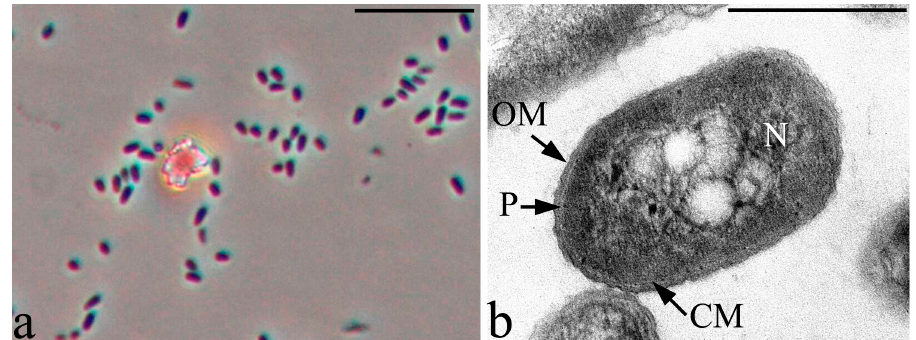
Figure 4. Phase contrast ( a ) and ultrathin section ( b ) of the strain 3 cells. Designations: OM—outer membrane, CM—cytoplasmic membrane, N—nucleoid and P—periplasm. Light microscopy. Phase contrast. Bar—10 µ m. Transmission Electron Microscopy. Bar—0.5 µ